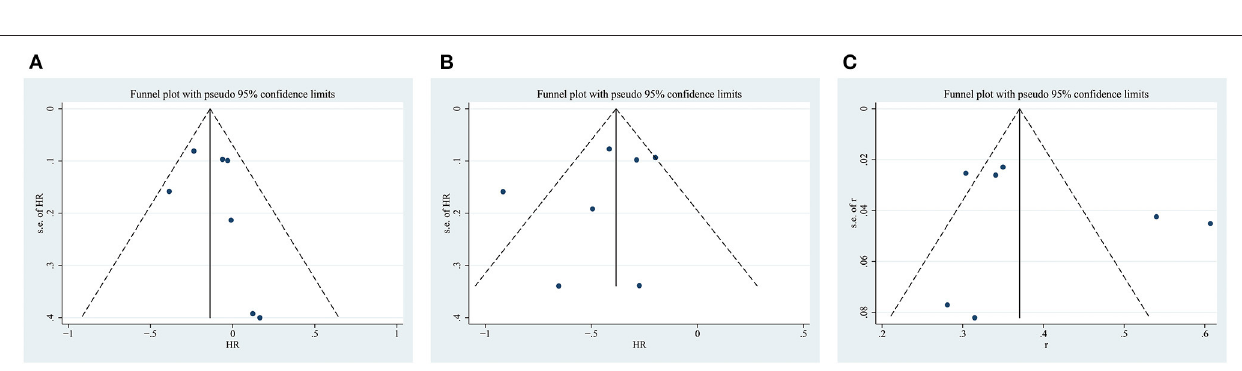
FIGURE 7 | Funnel plot for the (A) overall survival (OS), (B) progression-free survival (PFS), and (C) objective response rate